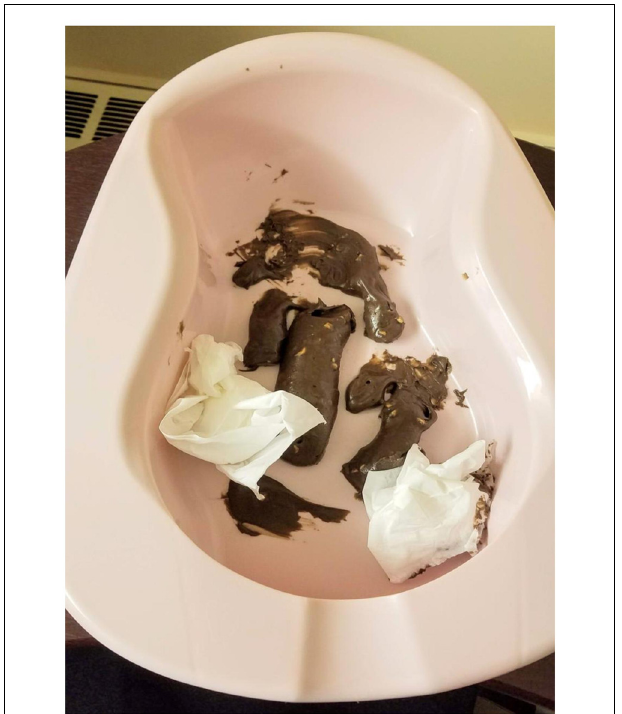
FIGURE 1 | The setup of the rubber hand illusion (RHI). The role of experimenter 1 was to continuously stroke the real and rubber hand during the stimulation period and that of experimenter 2 was to obtain ratings and conduct the remaining experimental procedures (contamination procedures, etc.).